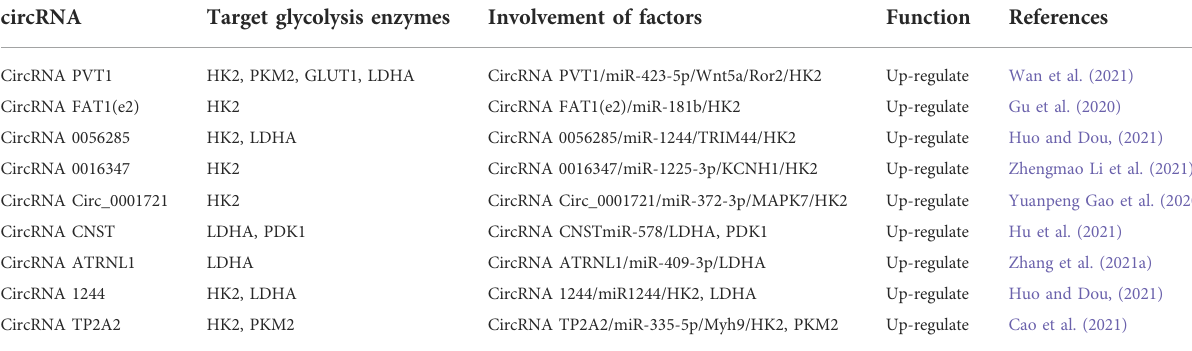
TABLE 5 cicrRNAs regulate glycolysis enzymes in osteosarcoma.